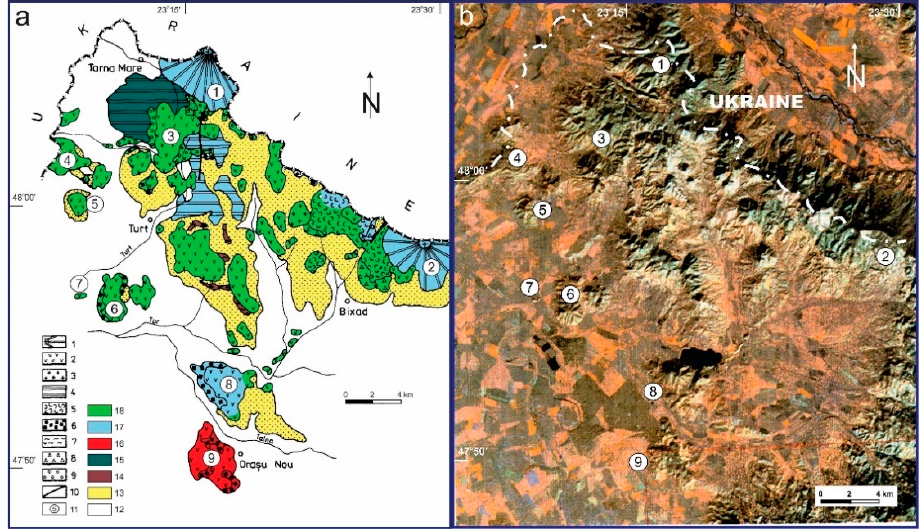
Figure 2. Volcanological map (modified after Kovacs and Fülöp [13]), ( a ) and geomorphological map/Landsat image ( b ) of the Oa ș Mountains Legend: 1. Composite volcanoes; 2. Extrusive domes; 3. Intrusions; 4. Volcano-tectonic depressions filled with lavas and volcaniclastics; 5. Lava flows (unknown centers); 6. Hyaloclastic deposits; 7. Pyroclastic flows; 8. Coarse volcaniclastics; 9. Fine volcaniclastics; 10. Faults; 11. The volcanic structures listed in the text: Composite volcanoes: 1. Dealul Negru; 2. Poiana ¸Sesu-Huta; Extrusive domes: 3. Batarci; 4. Hatu Lung; 5. Ple¸scu¸ta; 6. Pusta Heghii; 7. Turulung; 8. Jeleznic; 9. Ora¸su Nou; The color legend represents the sedimentary deposits and the main volcanic phases (as temporal evolution): 12. Quaternary sedimentary deposits; 13. Neogene sedimentary deposits; 14. C ă line¸sti Tuff complex; 15. Socea andesitic complex; 16. Ora¸su Nou rhyolitic lava-dome; 17. Volcanic rocks of the main andesitic phase (10.9–10.5 Ma); 18.